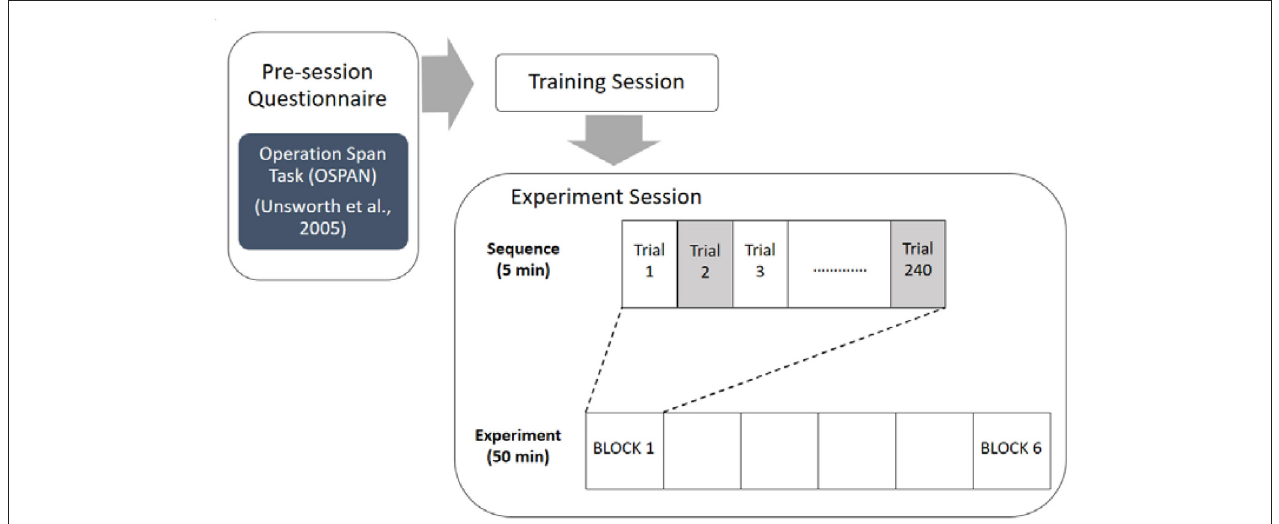
FIGURE 2 | Experimental